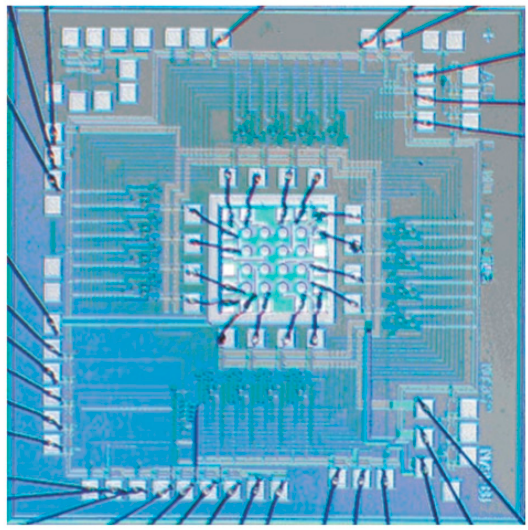
Figure 7. 4 × 4 GMAPD array wire bonded to CMOS timing circuits.